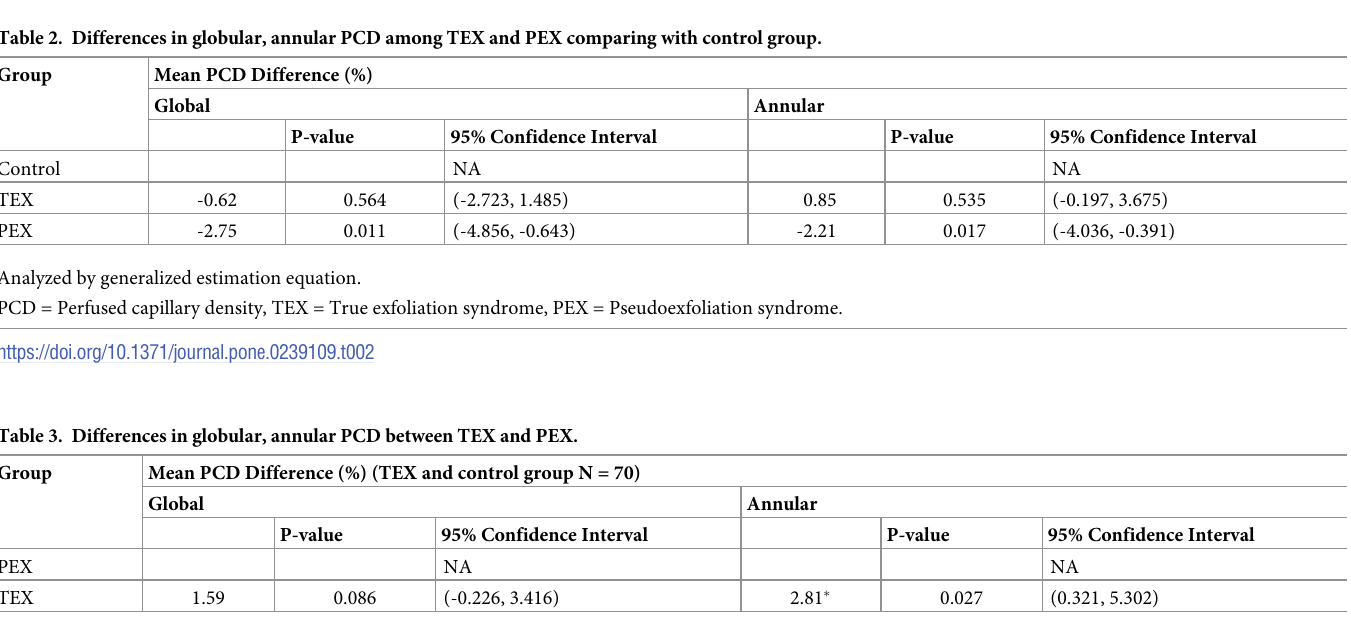
Analyzed by generalized estimation